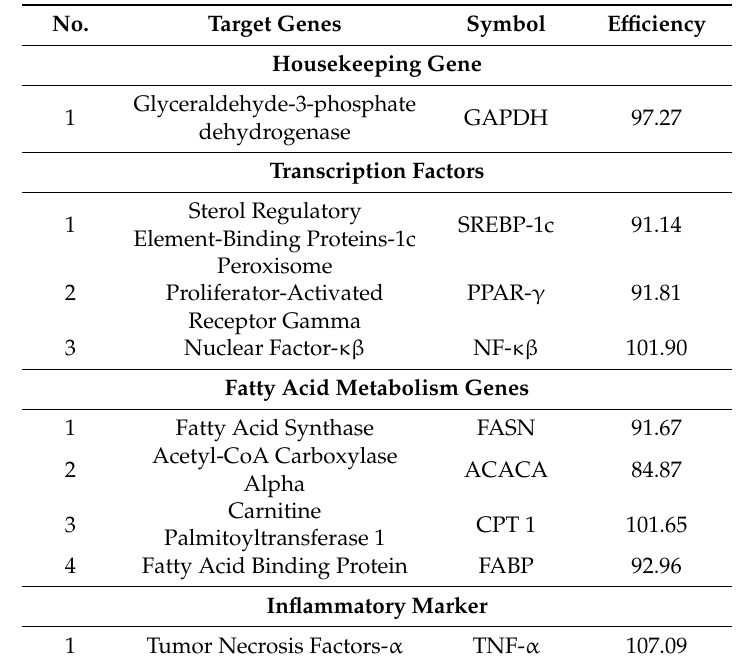
Table 7. The qRT-PCR e ffi ciency for absolute mRNA